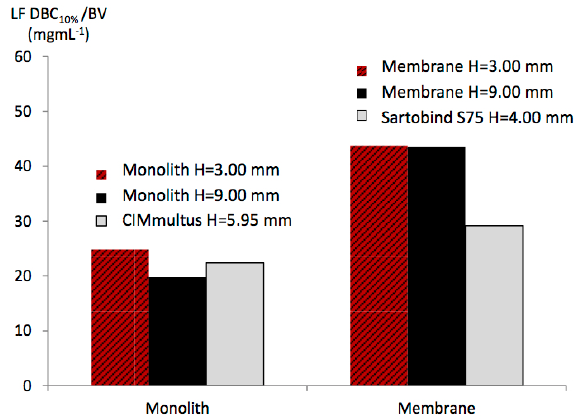
Figure 5. Comparison of LF DBC 10% per BV for the different chromatographic monoliths and membranes. The experiments were performed using 100 mM phosphate buffer at pH 6.0 at the initial BSA/LF ratio of 2/1. The operating flow rate was 12 BV · min − 1 , except for the monolith H = 9 mm, which was 0.4 BV · min − 1 .